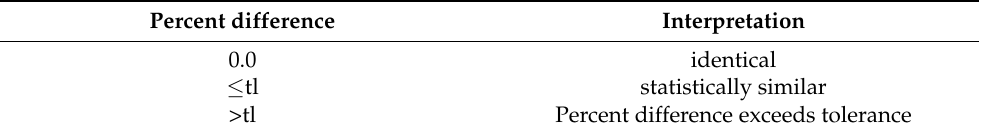
Table 2. Tolerance levels for validation. By default, the tolerance level (tl) is set to 0.05.